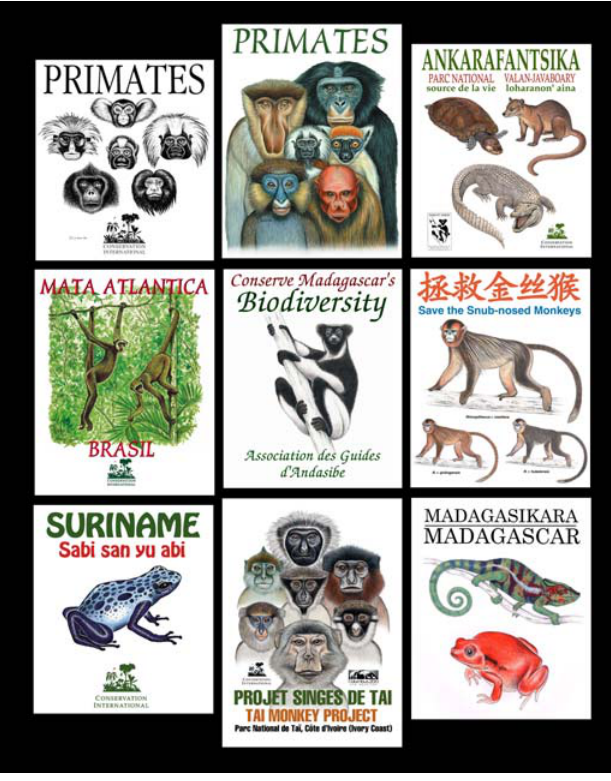
Image 8. Some examples of t-shirt designs created for various projects. The colors of the Malagasy flag are red, white and green, like the animals in the illustration at bottom left. (Illustrations by CI/Stephen D. Nash)